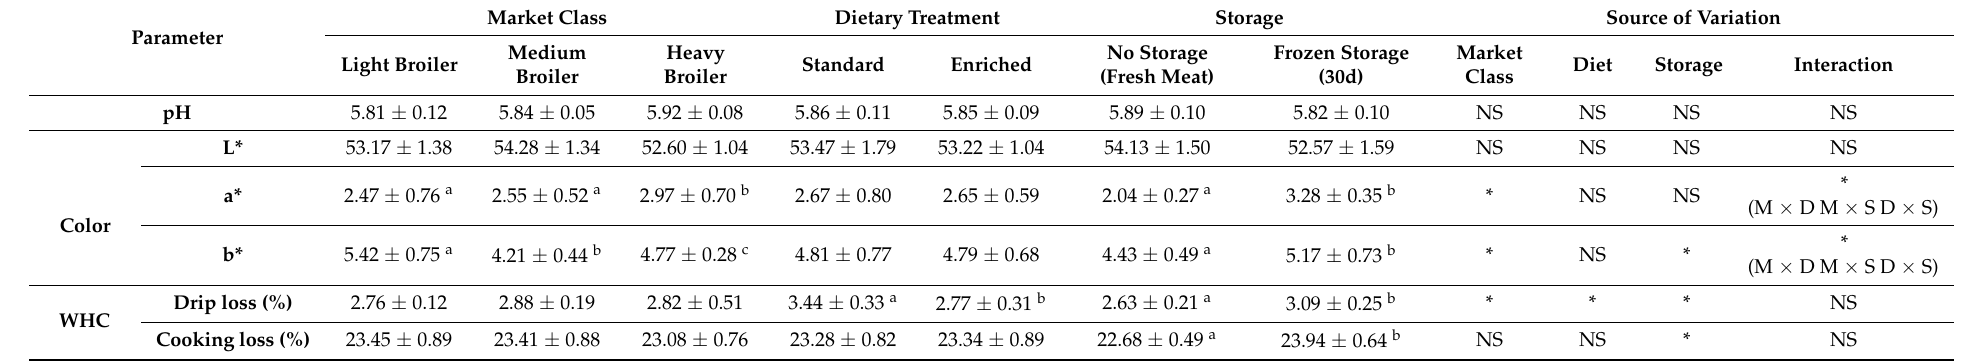
Table 2. Technological properties of control and functional breast fillets from light, medium, and heavy broilers at 24 h post-mortem and after freeze storage for 30 days. For every market class, data are reported in terms of mean ± standard deviation of n = 240 representative breasts from broilers receiving standard ( n = 120) and experimental ( n = 120) feeding, both at 24 h post-mortem ( n = 120) and following freeze storage ( n = 120). For the dietary treatment, data are expressed as mean ± standard deviation of n = 360 representative breast muscles from light ( n = 120), medium ( n = 120), and heavy ( n = 120) broilers, both in fresh status ( n = 180) and after freeze storage ( n = 180). For fresh or freeze stored samples, data are expressed as mean ± standard deviation of n = 360 representative breasts from light ( n = 120), medium ( n = 120), and heavy ( n = 120) broilers receiving both standard ( n = 180) and functional ( n = 180) feed.